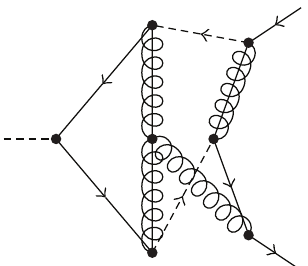
Figure 2: Sample diagram for the three-loop 𝑞𝑞𝜖 vertex where a nonvanishing trace with a single 𝛾 5 -matrix occurs. Solid lines are quarks, dashed lines are squarks, slashed springy lines are gluinos, and the external dashed line depicts an 𝜀 -scalar. The arrows on the lines denote the charge